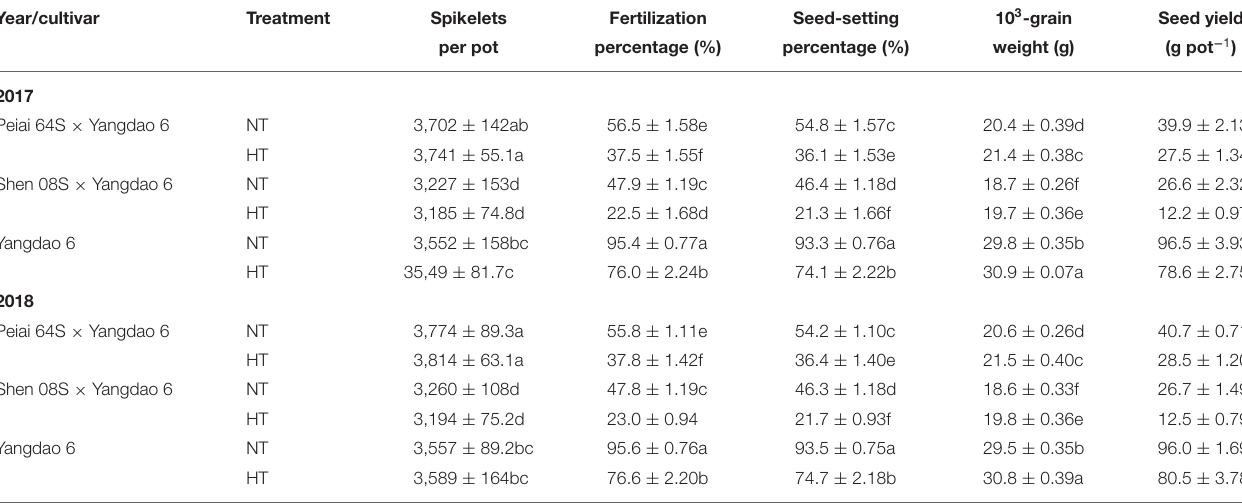
TABLE 2 | Effect of high-temperature stress during anthesis on the seed yield and its components of rice.